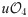
Set of all 11 graphlet-orbits of subgraphs with 4 nodes: uO4.Black nodes belong to the same graphlet-orbit.